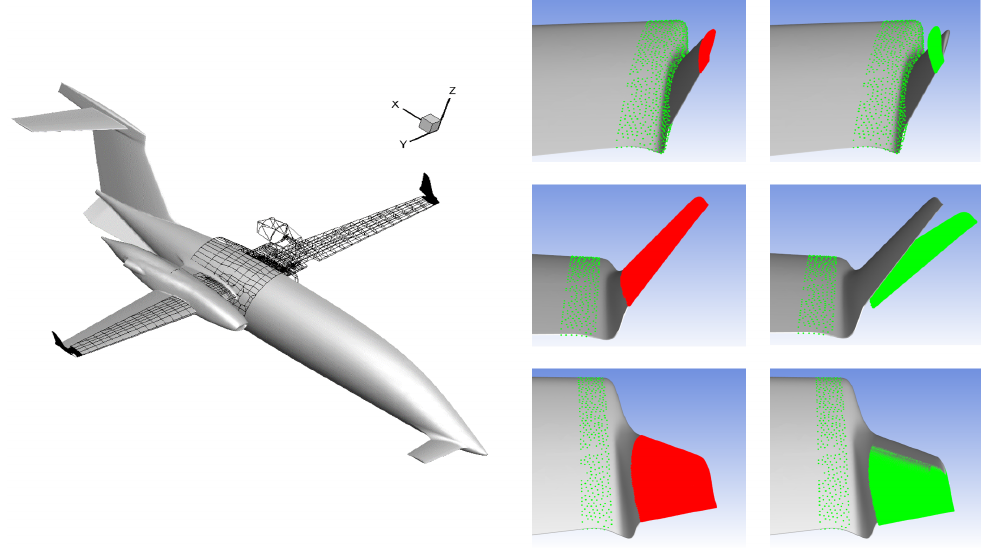
Figure 13. P180 CSM and CFD models. Right: RBF setup for the P180 shape parameters [54].